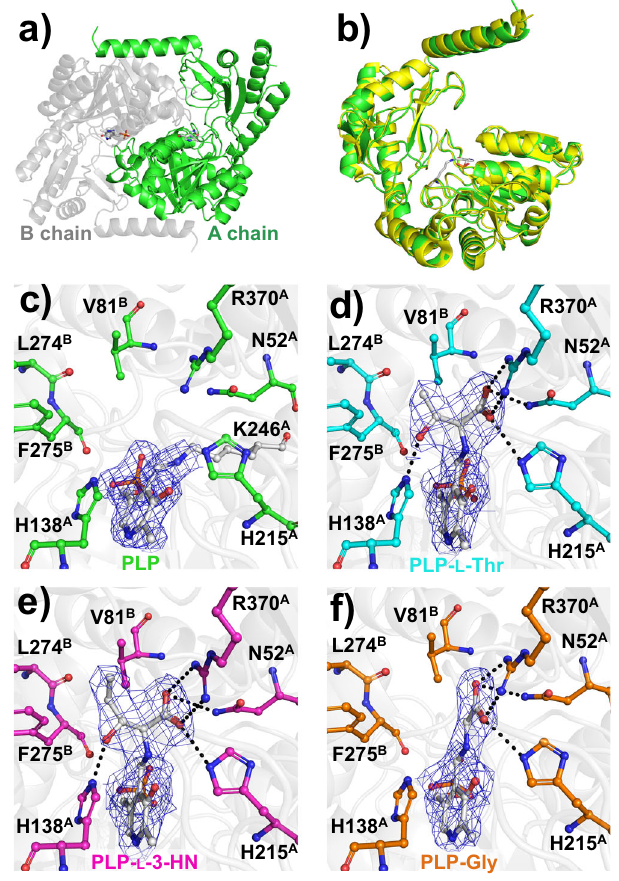
Fig. 5 Crystal structures of CnKBL(WT) and K246A variants. a Overall structure of CnKBL. The dimer is shown as green and gray. PLP is shown as a stick model. b Superposed structures of CnKBL (green) and EcKBL (yellow, PDB ID: 1FC4). Active site structures of CnKBL(WT) and the K264A variant. Here, structures of the ligand-free form of CnKBL(WT), L- Thr, L-3-HN, and Gly binding forms of CnKBL(K264A) variants were represented as green ( c ), cyan ( d ), magenta ( e ), and orange ( f ), respectively. The hydrogen bonds formed between CnKBL and substrates were represented as dotted lines when the bond length was less than 3.4 Å. The 2Fo-Fc electron density map (blue mesh) is contoured at 1.0 σ